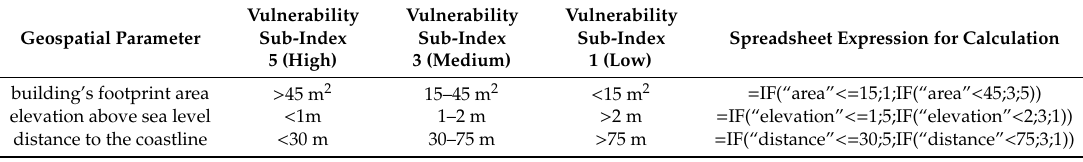
Table 1. Crisp ranking by scores: the vulnerability sub-indices V area , V elevation, and V distance .